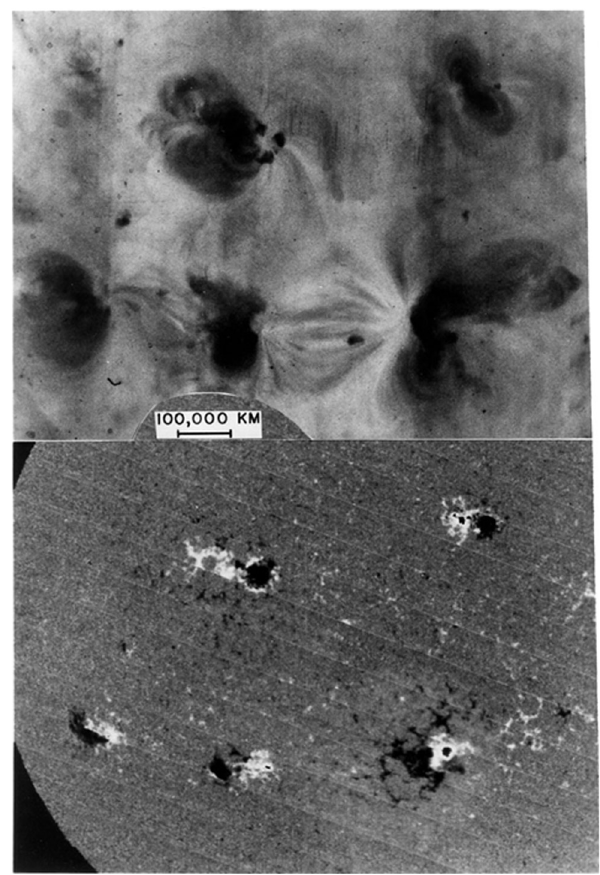
Fig. 6a. The magnetic field lines among five sunspot pairs (two in the Northern Hemisphere and three in the Southern Hemisphere) are connected almost as in a vacuum, in spite of the fact that they are embedded in a highly conductive plasma (Sheeley et al., 1975).